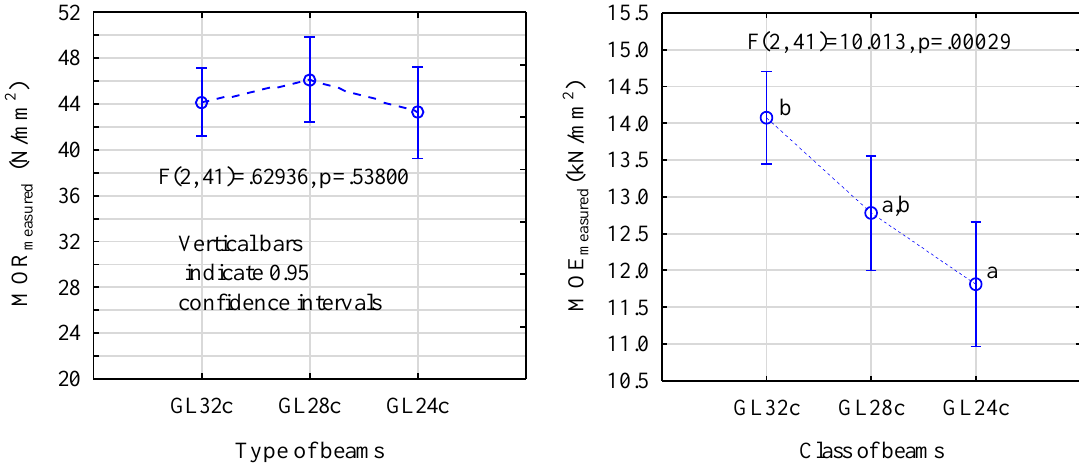
Figure 5. A one-factor ANOVA for the system: glued beam’s grade—static bending strength; and beam’s grade—modulus of elasticity. The letters denote uniform groups for Tukey’s test.